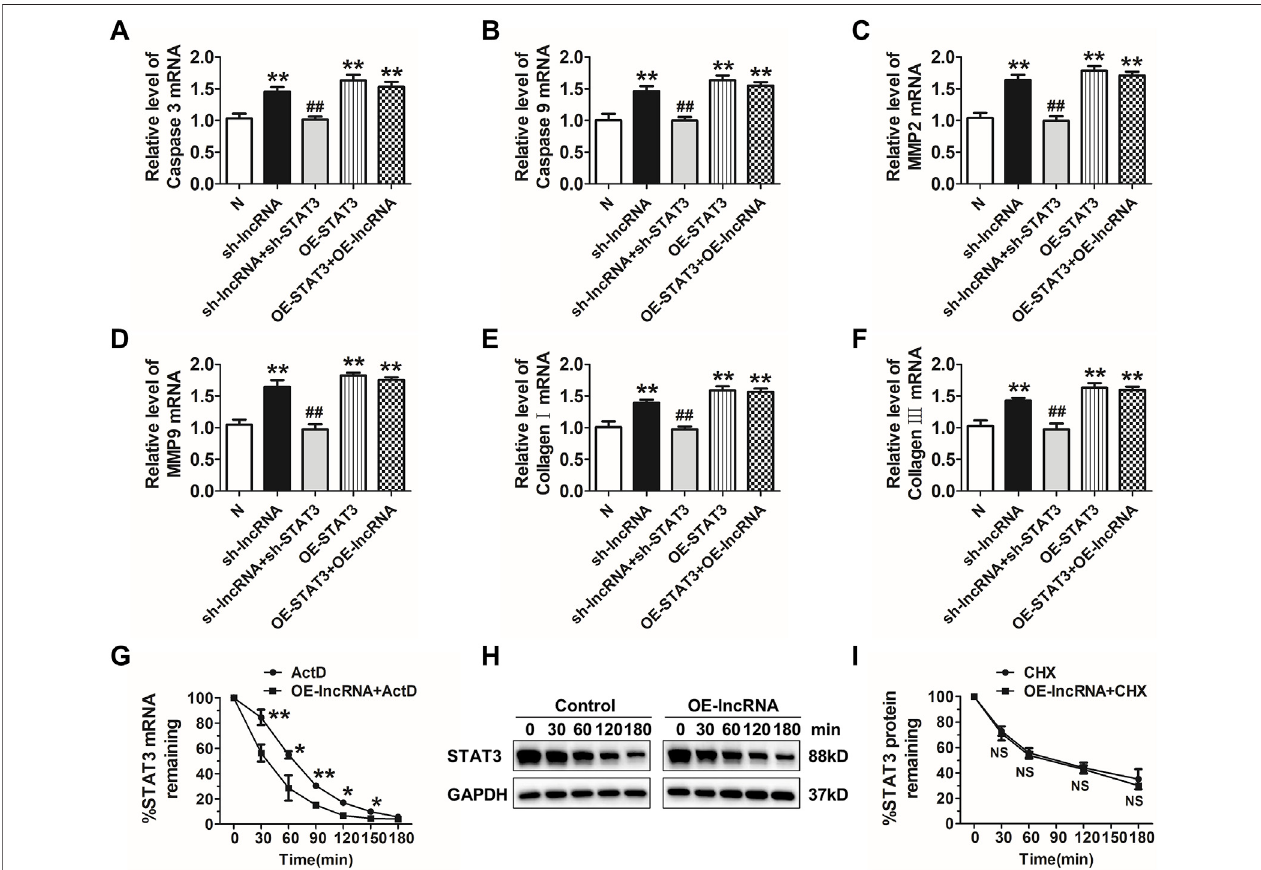
FIGURE8| Lnc-C2orf63-4-1restoresapoptosis, fi brosis,andMMP-2/9activityviadestabilizingSTAT3mRNAinVSMCs. (A,B) qRT-PCRanalysisresultsshowed that lnc-C2orf63-4-1 silencing by lentivirus vector carrying a lnc-C2orf63-4-1-shRNA fragment promoted the expression of apoptosis-related markers via induction of the STAT3 ( n (cid:1) 6/per group). (C,D) qRT-PCR analysis results showed that lnc-C2orf63-4-1 silencing by lentivirus vector carrying a lnc-C2orf63-4-1-shRNA fragment promoted the expression of MMP-2 and MMP-9 via induction of the STAT3 ( n (cid:1) 6/per group). (E,F) qRT-PCR analysis results showed that